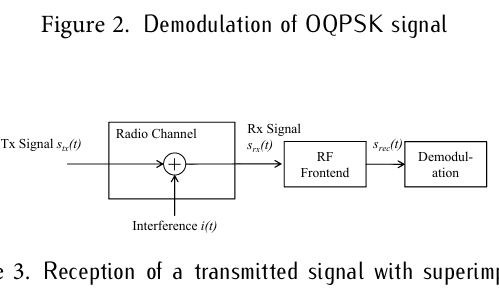
Figure 3. Reception of a transmitted signal with superimposed interference from a concurrent transmitter